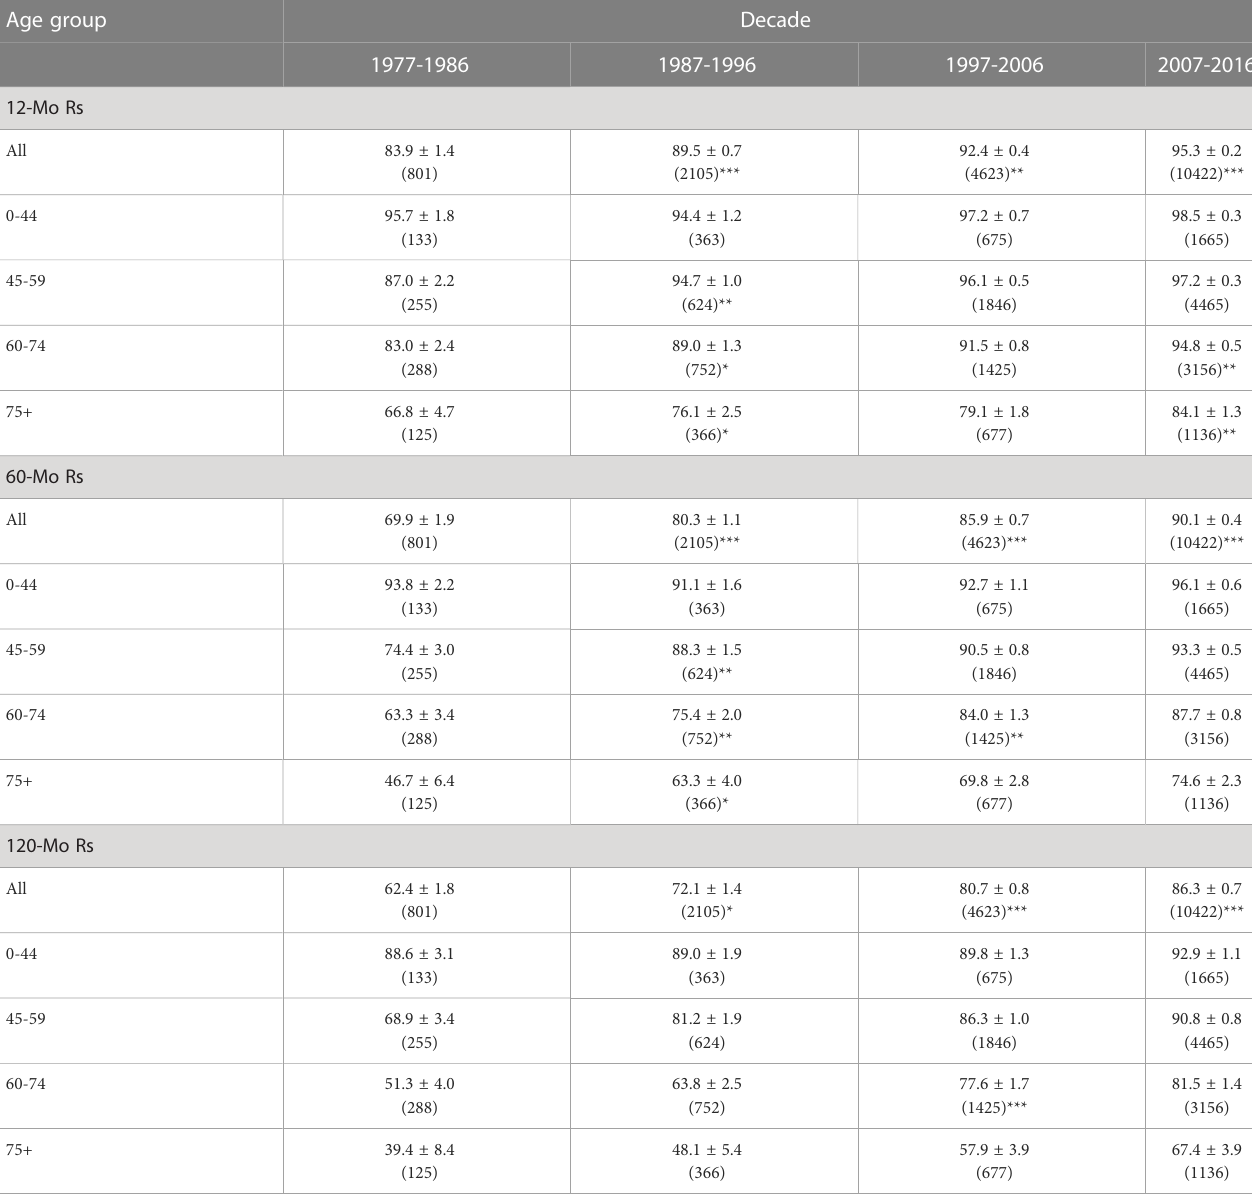
TABLE 1 Relative survival rates of GI-NETs during the periods of 1977-1986, 1987-1996, 1997-2006, and 2007-2016 at nine SEER